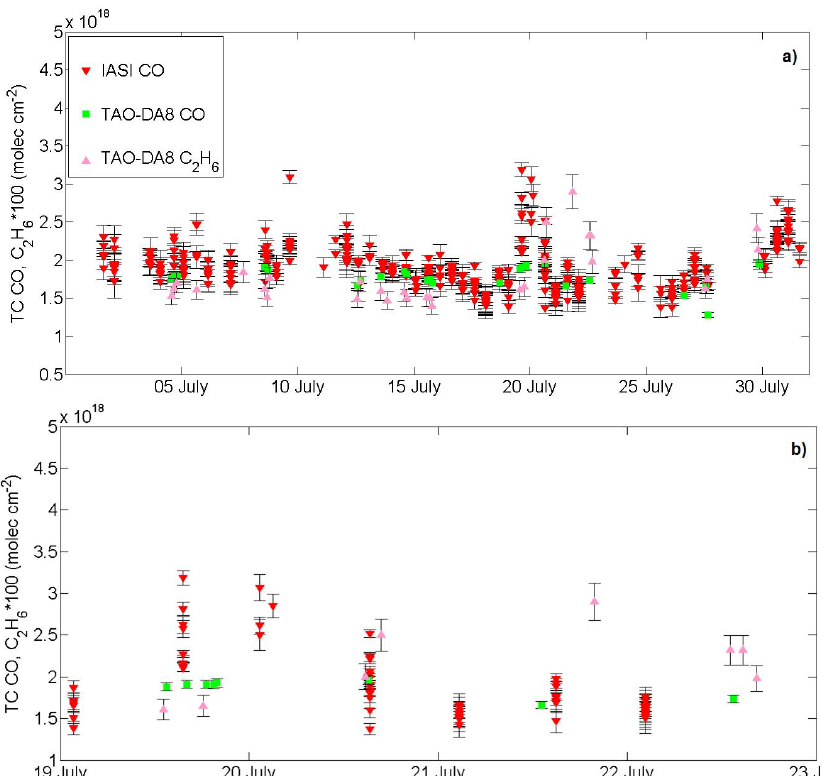
Fig. 3. The total column (TC) measurements in Toronto are shown for CO and C 2 H 6 for (a) July 2011 and (b) between 19 and 22 July 2011. CO from TAO-DA8 (green squares), CO from IASI (red inverted triangles), and C 2 H 6 from TAO-DA8 (pink triangles) are shown. The labels on the x axes indicate the start of the day at 00:00UTC. Note that the C 2 H 6 columns are scaled by a factor of 100. The black bars indicate the estimated uncertainties for each gas and instrument, as described in Table 1 and Sect.